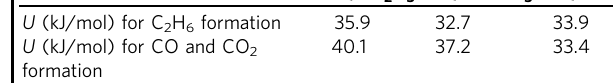
the different band-gap energy that the photocatalytic activation of the robust C – H bond of methane is ef fi ciently accelerated by interfacial water species at ambient temperatures and pressures.